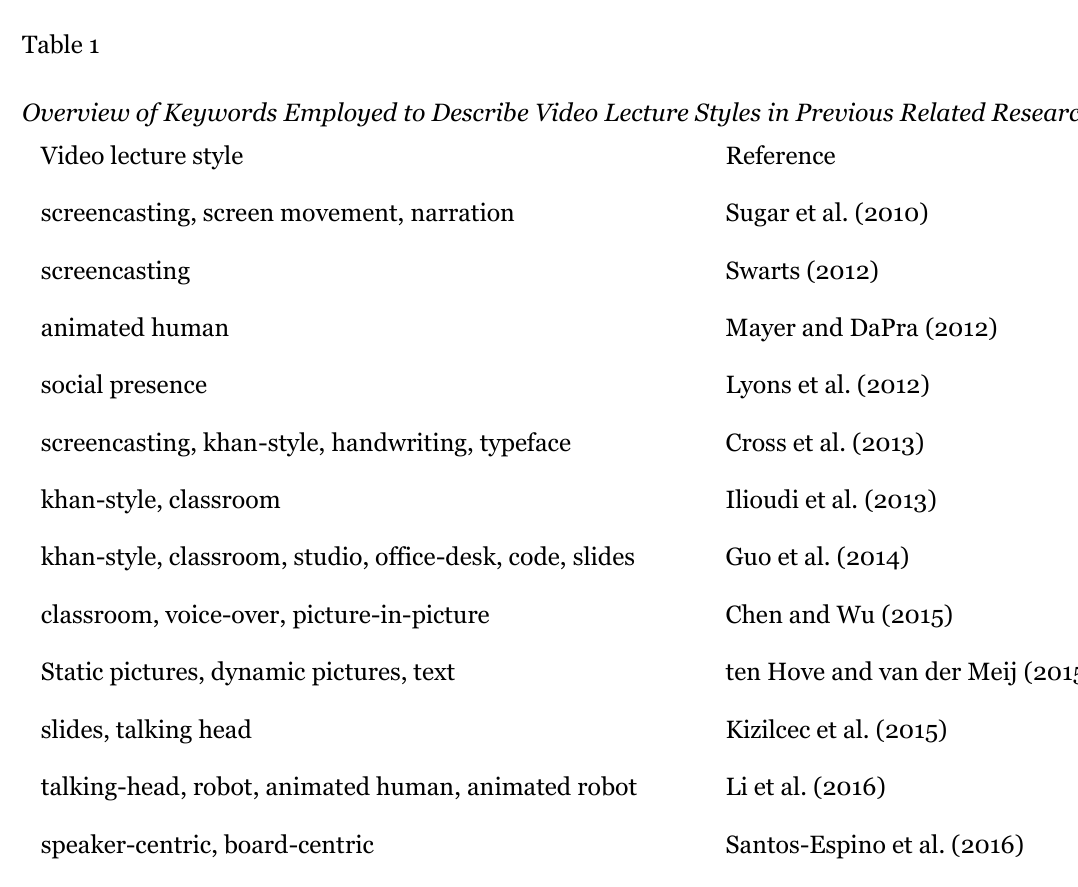
Overview of Keywords Employed to Describe Video Lecture Styles in Previous Related Research Video lecture